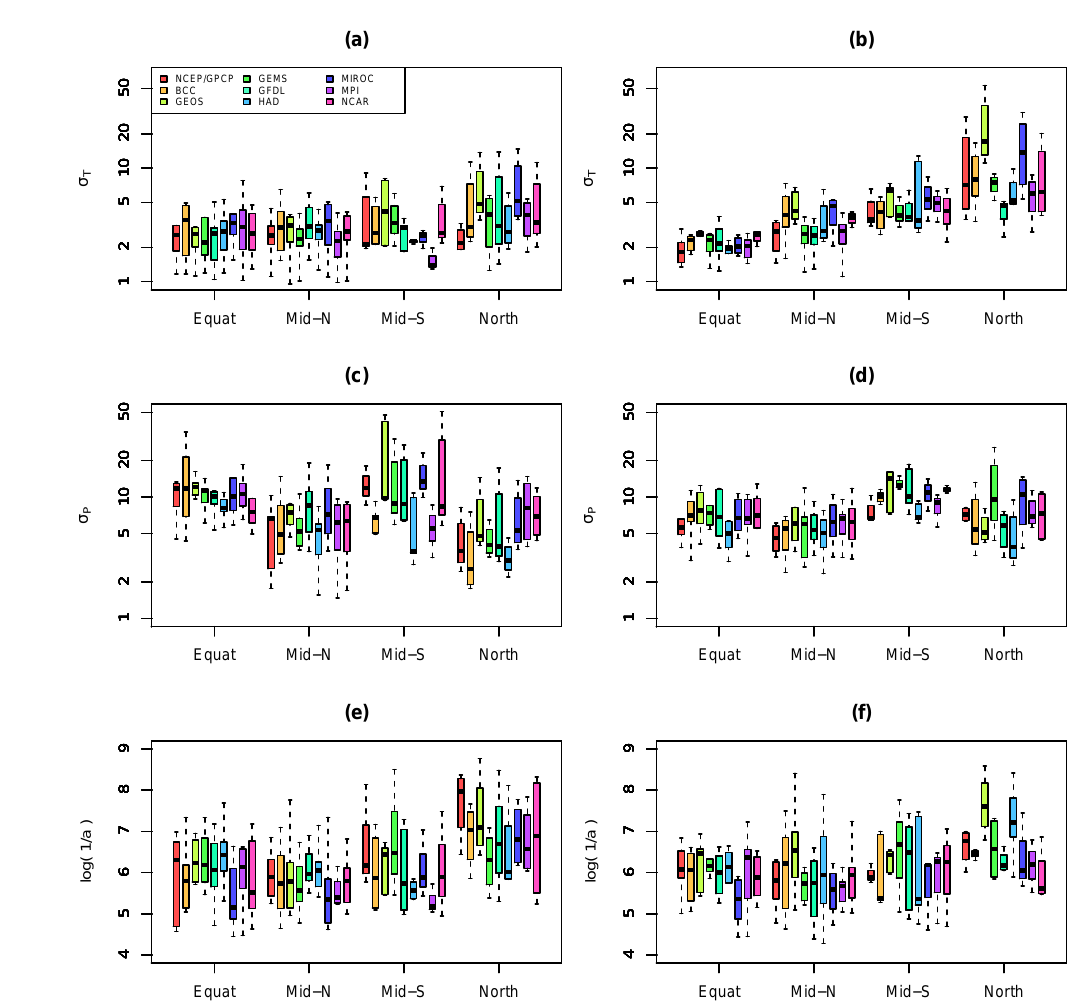
Figure 9. Parameter estimates by source for each season by latitude band, for JJA (left column) and DJF (right column). (a) JJA and (b) DJF for ˆ σ T , (c) JJA and (d) DJF for ˆ σ P , and (e) JJA and (f) DJF for 1 / ˆ a (in log scale).